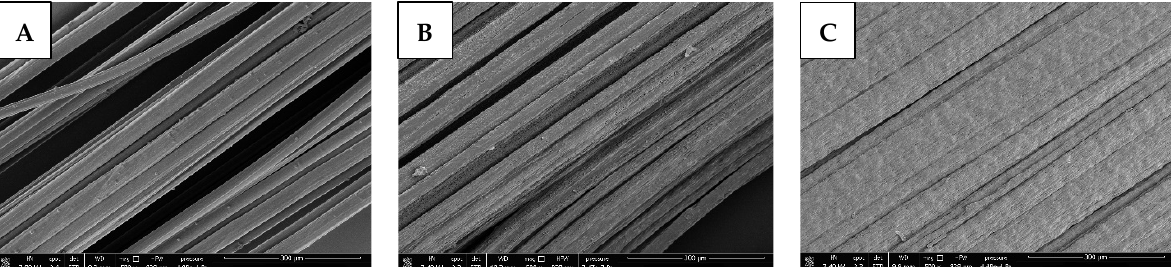
Figure 2. SEM images of the morphologies of melt- and wet-spun SMP yarns: ( A ) DesmoM80, ( B ) DesmoW2.2, and ( C ) DesmoW3. Scale bar = 300 µm.